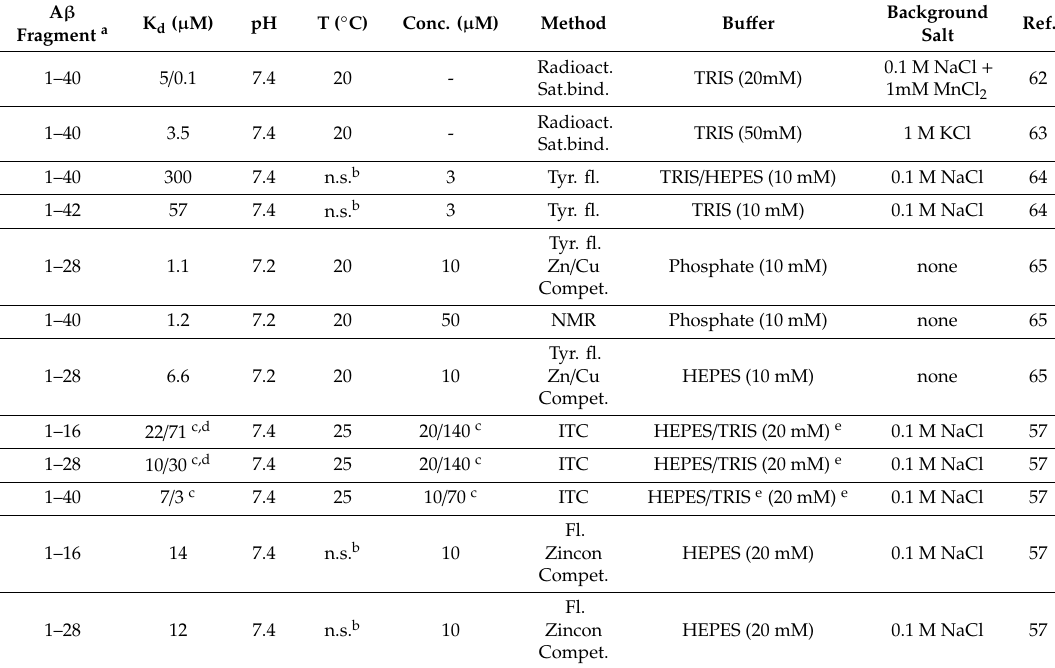
Table 1. Literature values for Zn 2 + binding to A β